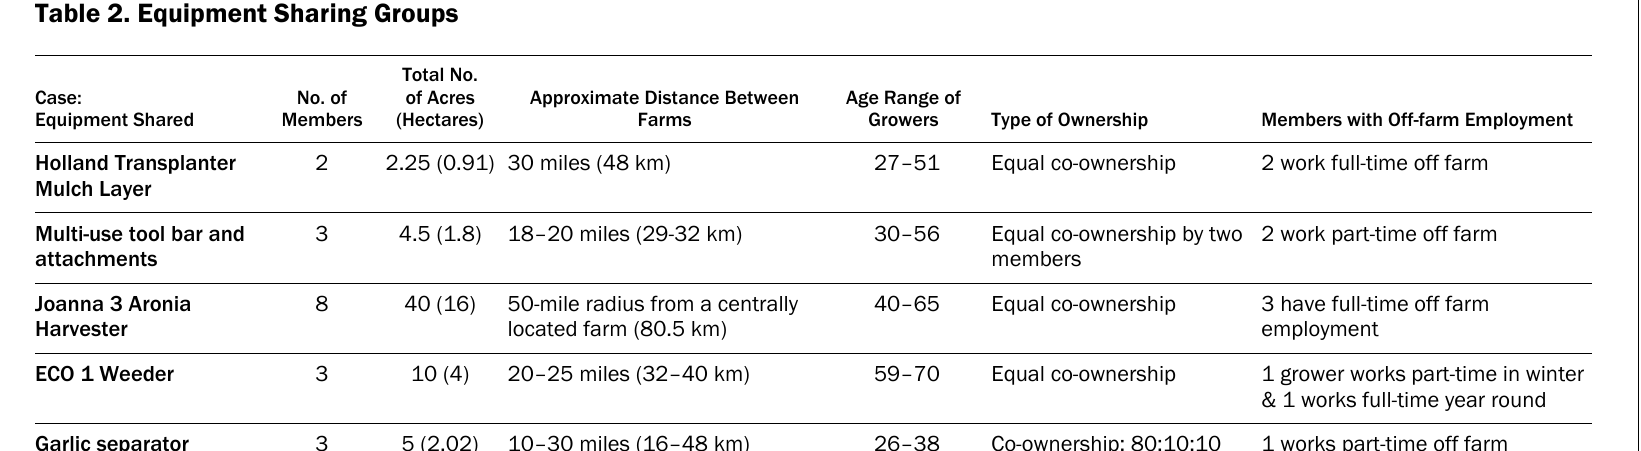
Table 2. Equipment Sharing